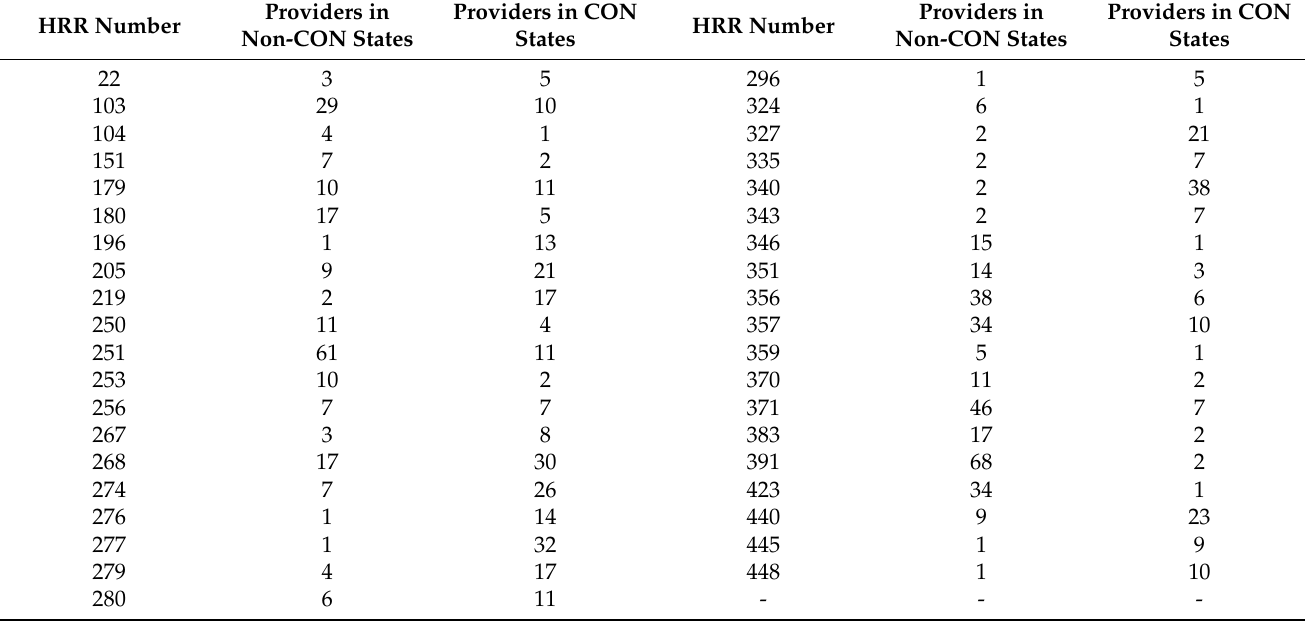
Table 3. Number of providers in HRRs that crossed the borders of states with and without CON laws